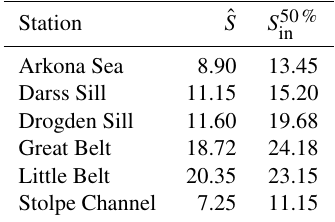
Table B1. Modelled salinity thresholds for selected transects (g kg − 1 ).